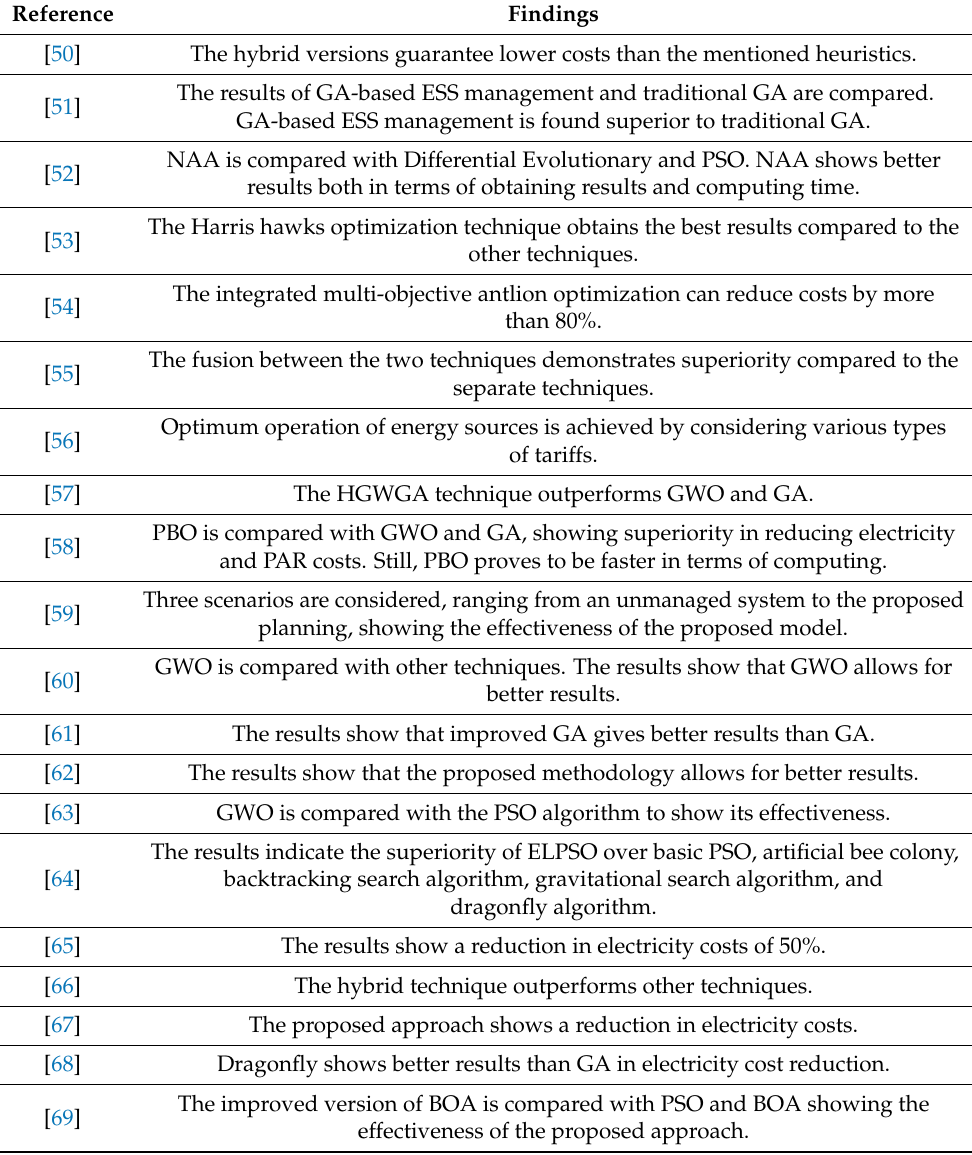
Table 14. Findings of selected papers associated with heuristics and metaheuristics excluding reinforcement